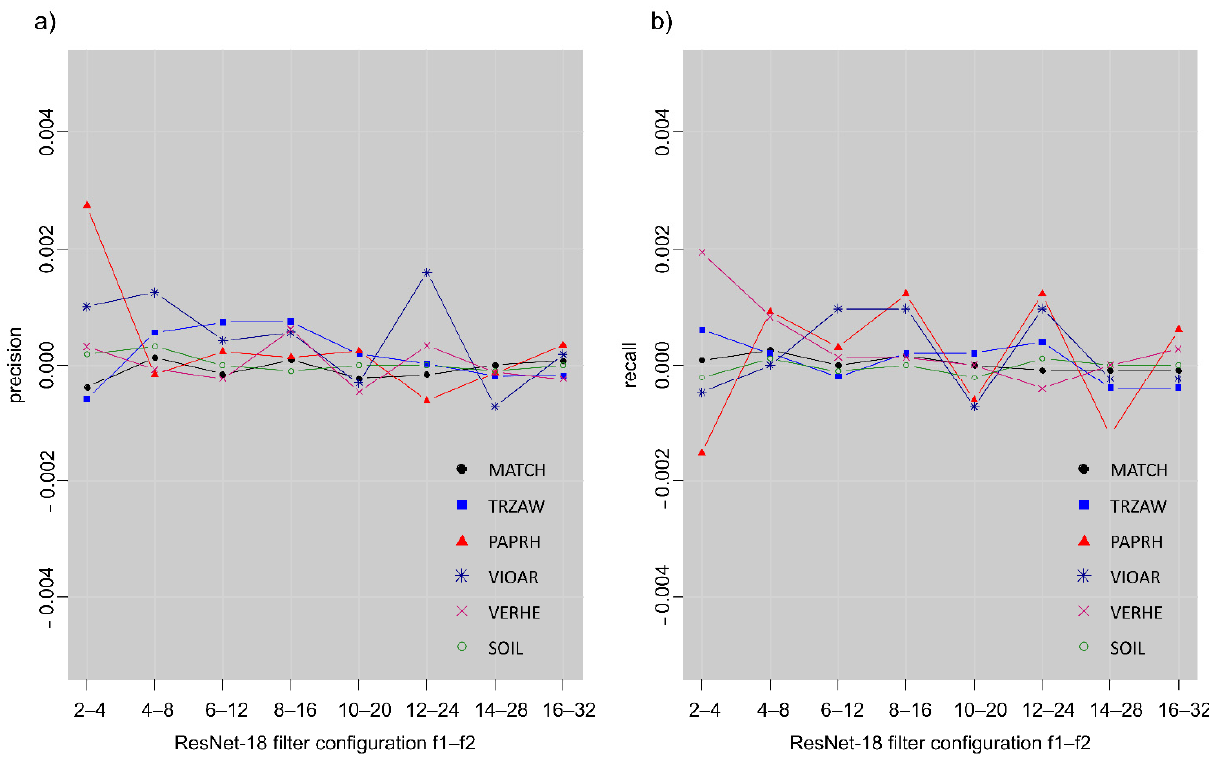
Figure 6. Differences between 32- and 16-bit resolution regarding model testing for precision ( a ) and recall ( b ) results in relation to filter configuration. Model results for each filter configuration were aggregated from five model runs with different randomization (seeds) of the weights.